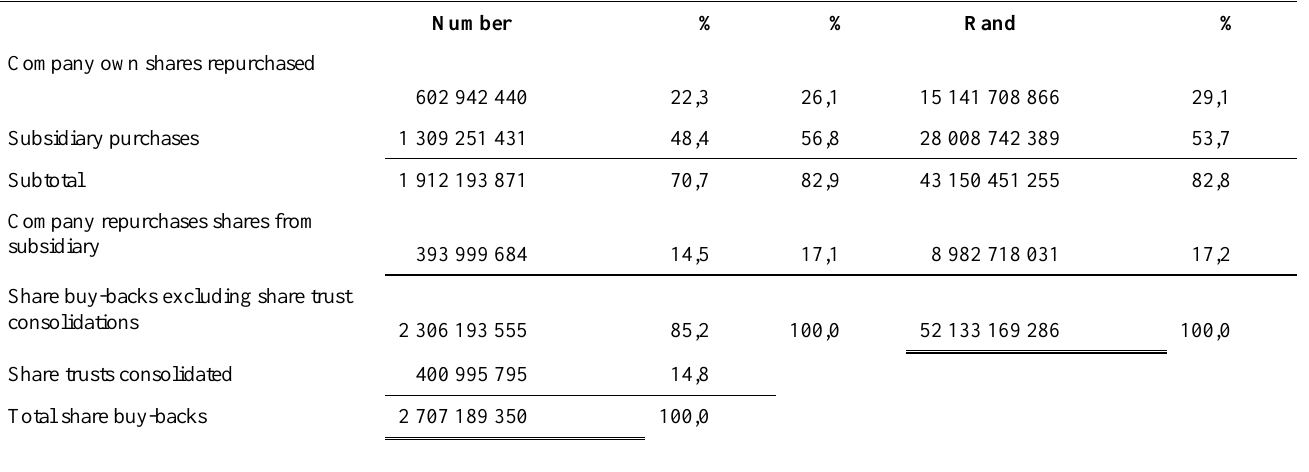
Table 4: Share buy-backs by repurchasing entity